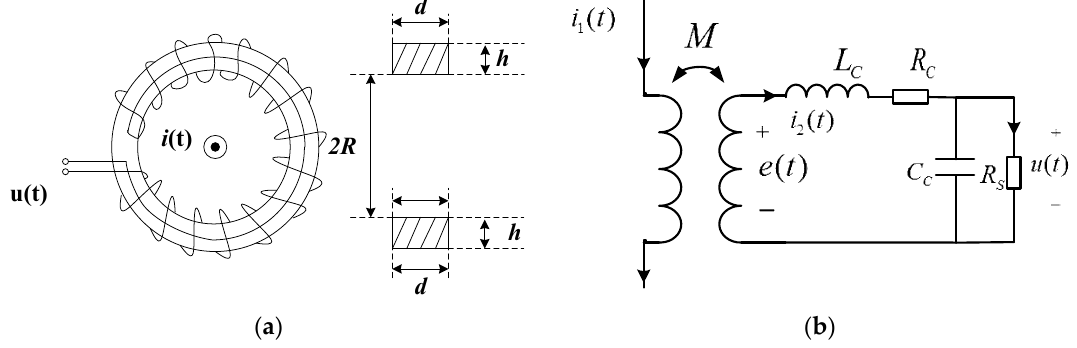
Figure 1. Principle of a Rogowski Coil. ( a ) Structure Diagram of a Rogowski coil; ( b ) Equivalent circuit of a Rogowski coil.